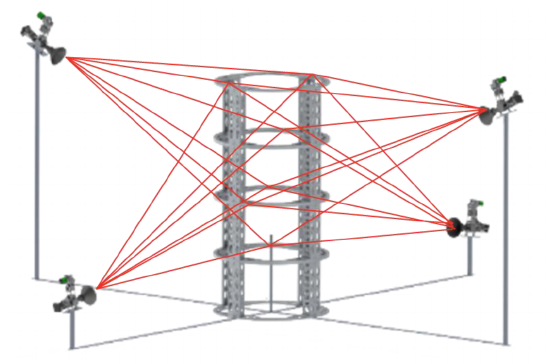
Figure 1. OPTIMUM instrument setup to measure a large measurement volume containing multiple targets and sensors simultaneously the targets in the image. The image coordinates of the targets were used to determine the direction in which to send FSI laser beams to make the range measurements. The laser